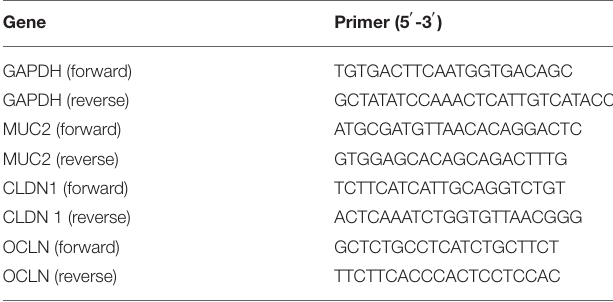
TABLE 2 | Primers used for real-time PCR a